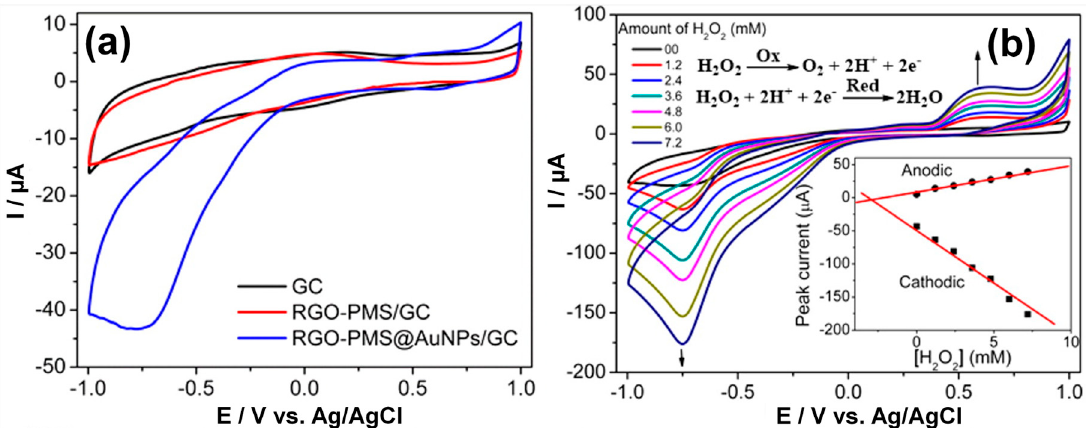
Figure 10. ( a ) CVs of GC, RGO ‐ PMS/GC, and RGO ‐ PMS@AuNPs/GC electrodes in 0.1 M PBS; ( b ) CVs of RGO ‐ PMS@AuNPs/GC electrode in the absence and presence of H 2 O 2 (inset: corresponding calibration plots). Note: the scan rate (in mV ∙ s − 1 ) was not provided, which is extremely disappointing for any comparison with other data within the literature. Reprinted and adapted with permission from Reference [129]. Copyright American Chemical Society, 2014.